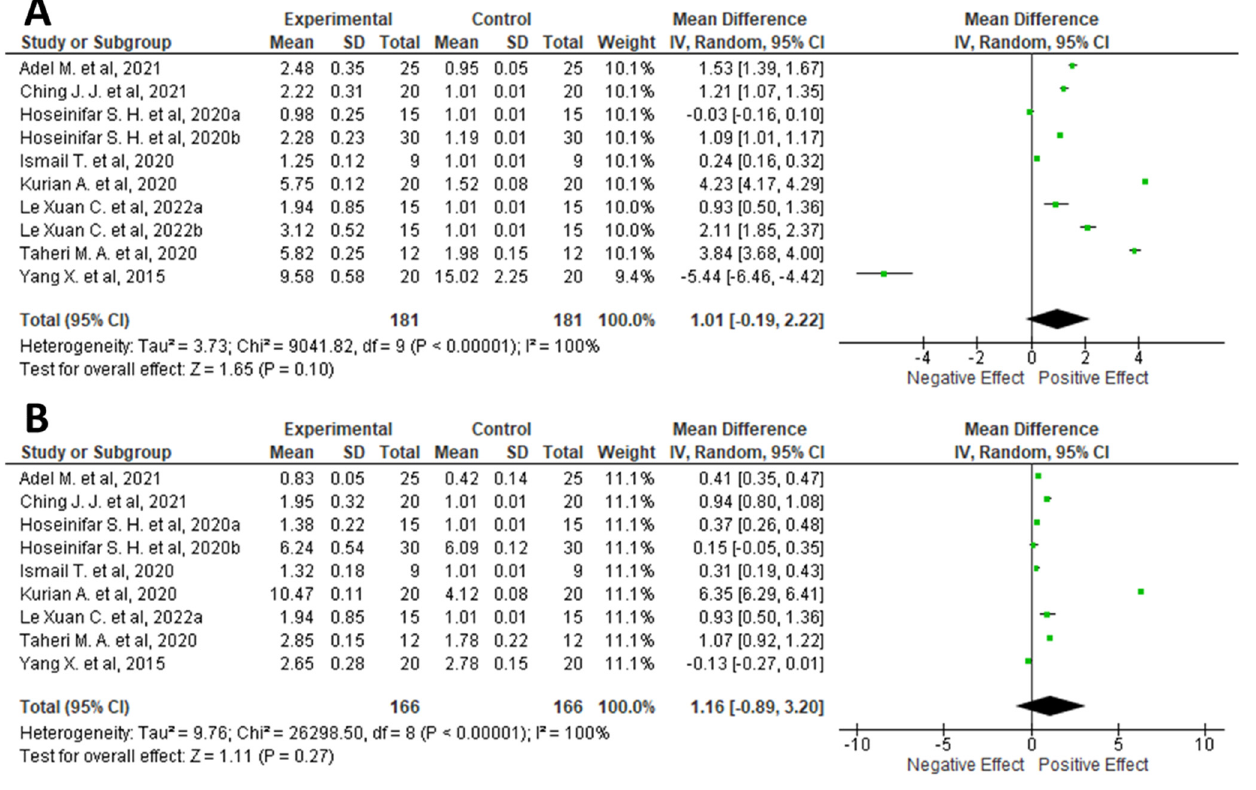
Figure 5. Forest diagram representation of the effects on Interleukin-1 β (IL-1 β ) ( A ) and Tumor Necrosis Factor α (TNF- α ) ( B ) resulting from supplementing fish diets with plant waste. Data were extracted from nine articles [33–38,40,42,43] and plotted against the mean difference. Each horizontal line in the graph represents an individual and specific study, with the experimental mean value displayed as a green box. For each study, if the horizontal line (95% CI) crosses the vertical line (absence of effect), no statistically significant differences can be observed between the experimental and control group. The black diamond at the bottom of the forest plot represents the average effect size calculated from the combination of the results from all selected studies. The output was generated via Review Manager (RevMan) [Computer program]. Version 5.4. The Cochrane Collaboration, 2020.